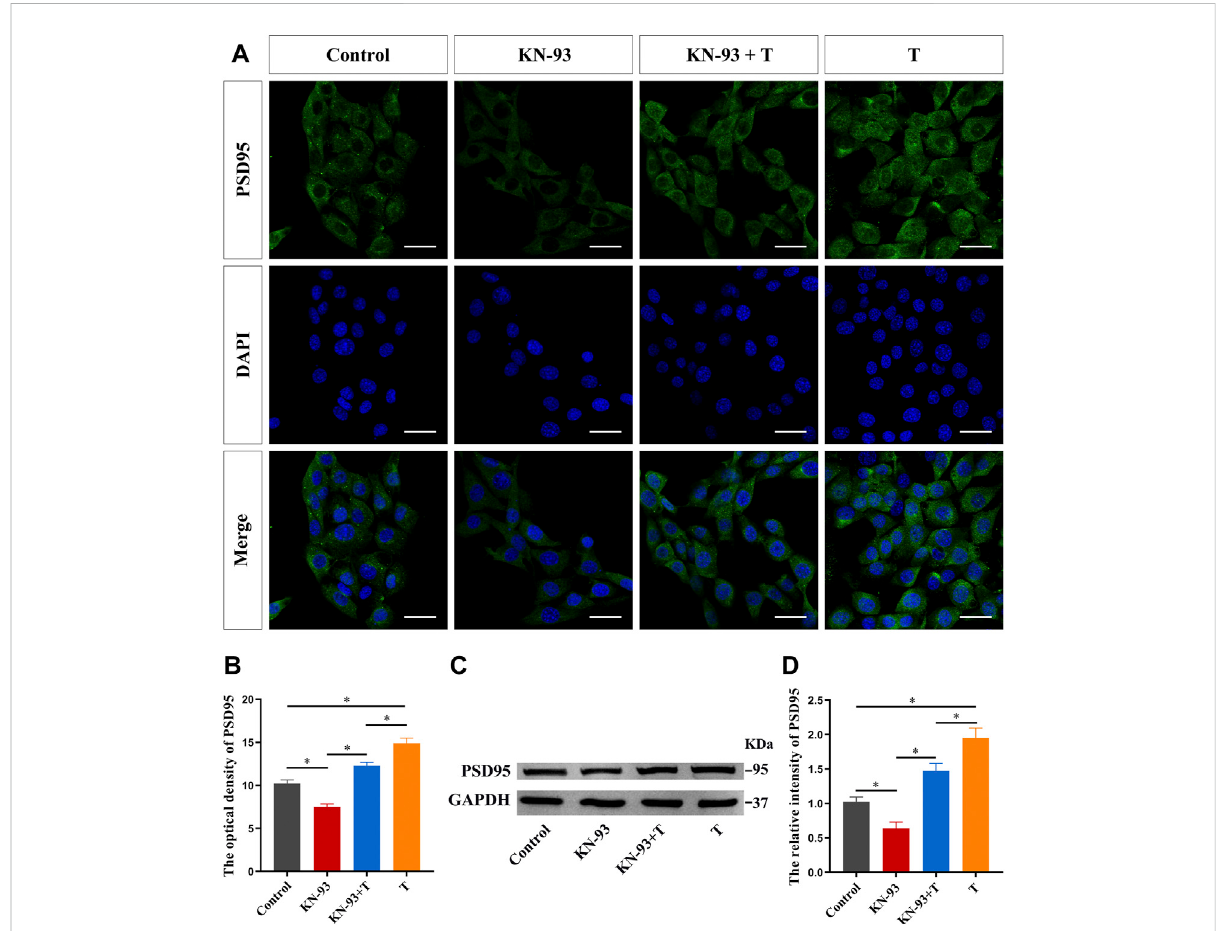
FIGURE 9 CaMKII protein is involved in the T-induced increase of synaptic protein PSD95 in HT22 cells. (A) Immuno fl uorescence cytochemistry of PSD95 expression in HT22 cells pre-treated with T or KN-93. (B) Statistical graph of immuno fl uorescence cytochemistry for PSD95 expression in HT22cellspre-treatedwithTorKN-93.Scalebars=20 μ m. (C) WesternblottingforPSD95expressioninHT22cellspre-treatedwithTorKN-93. (D) Statistical graph of western blot analysis of PSD95 expression in HT22 cells pre-treated with T or KN-93 (* p <